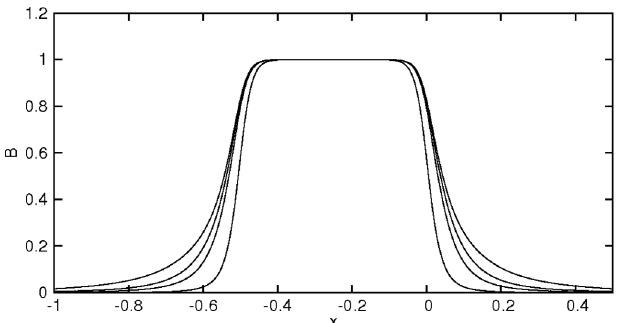
FIG. 6. Field profiles for dipole magnets with various values of d=a . In order from inner to outer curves, the d=a values are 0.0, 1.0, 2.0, and 5.0, respectively. All magnets have 2 a ¼ 0 : 1 , 2 b ¼ ¼ 1 0 : 5 , and B 0